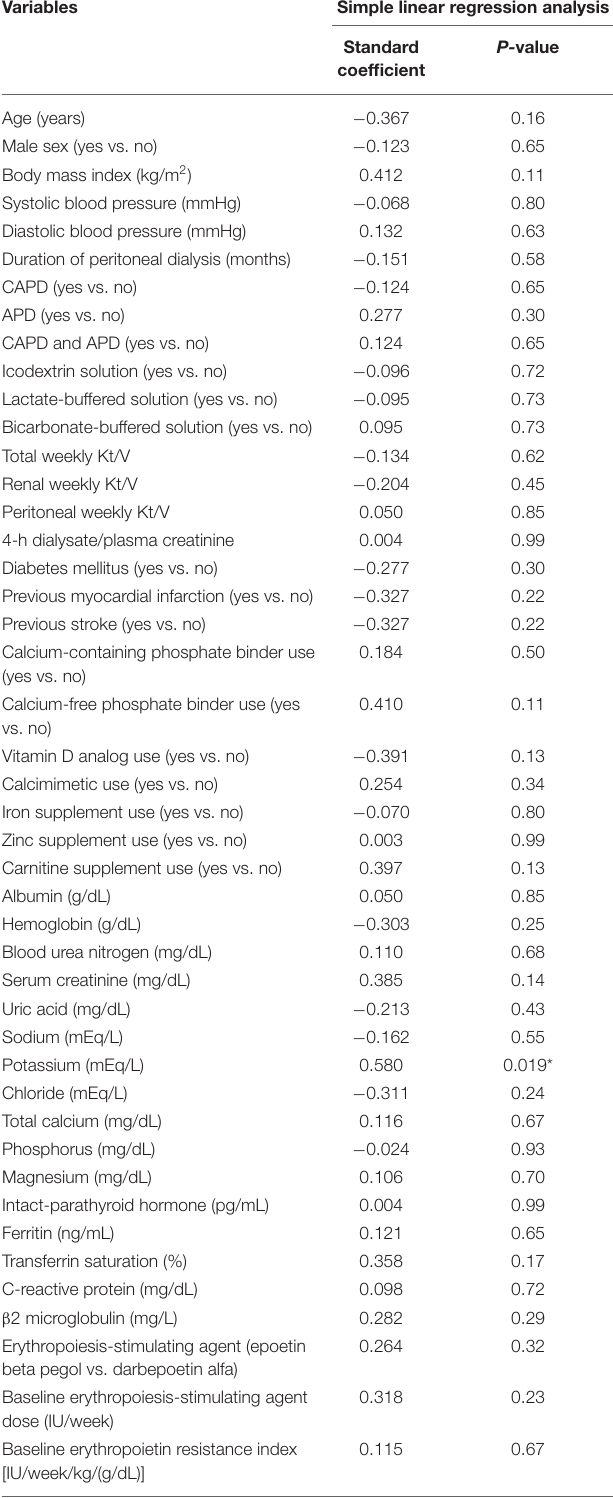
TABLE 2 | Simple linear regression analyses of the variables correlated with the dose of roxadustat at + 24 weeks. Variables Simple linear regression analysis Standard